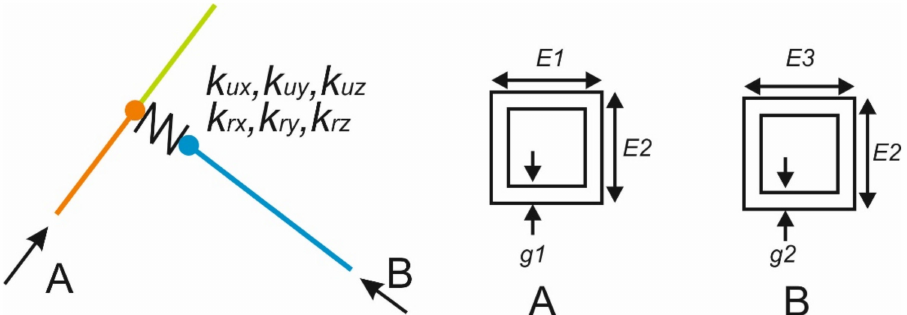
Figure 3. Alternative T-junction